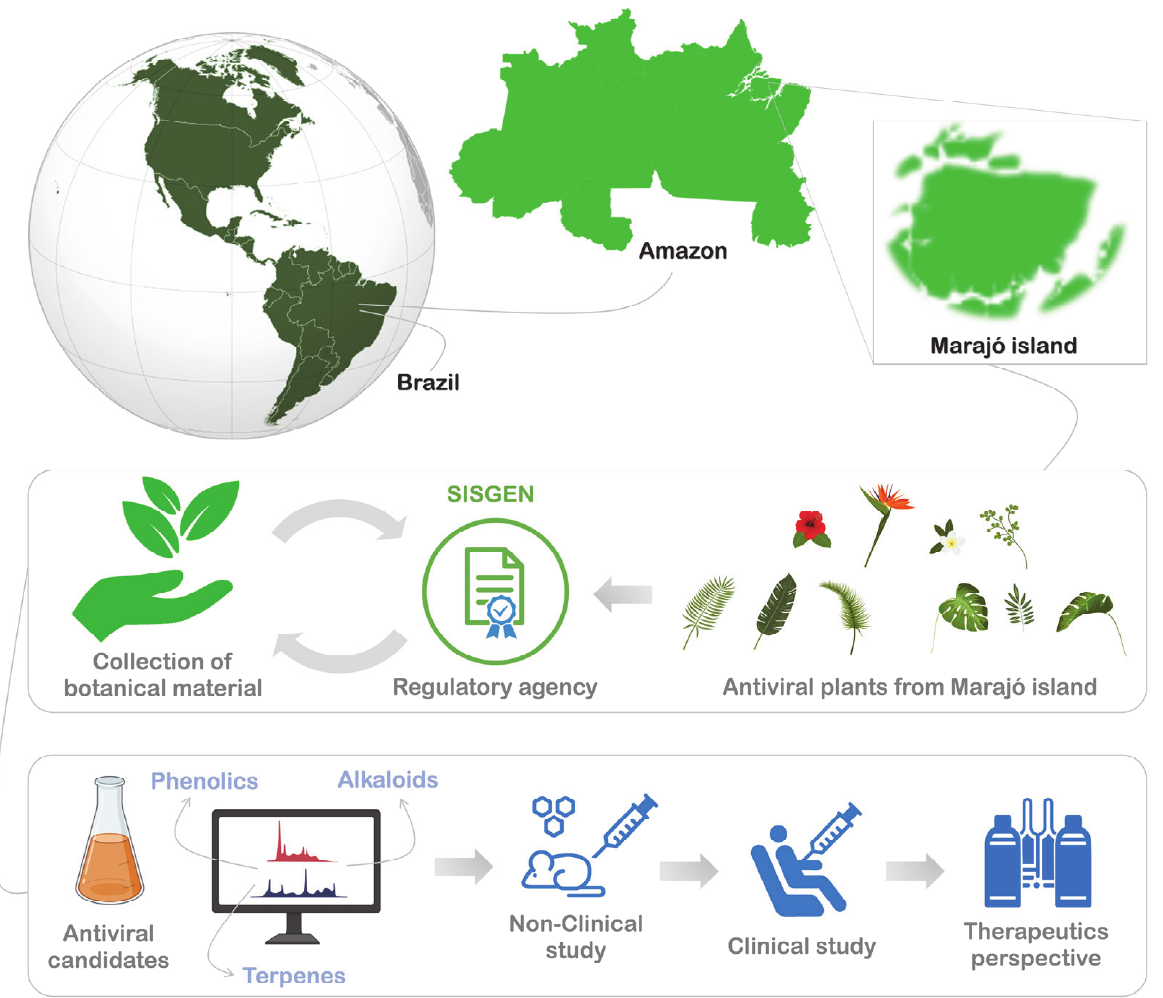
Figure 3. Future prospects for the use of medicinal plants from Marajó island for the discovery of antiviral candidates and the development of therapeutic alternatives.